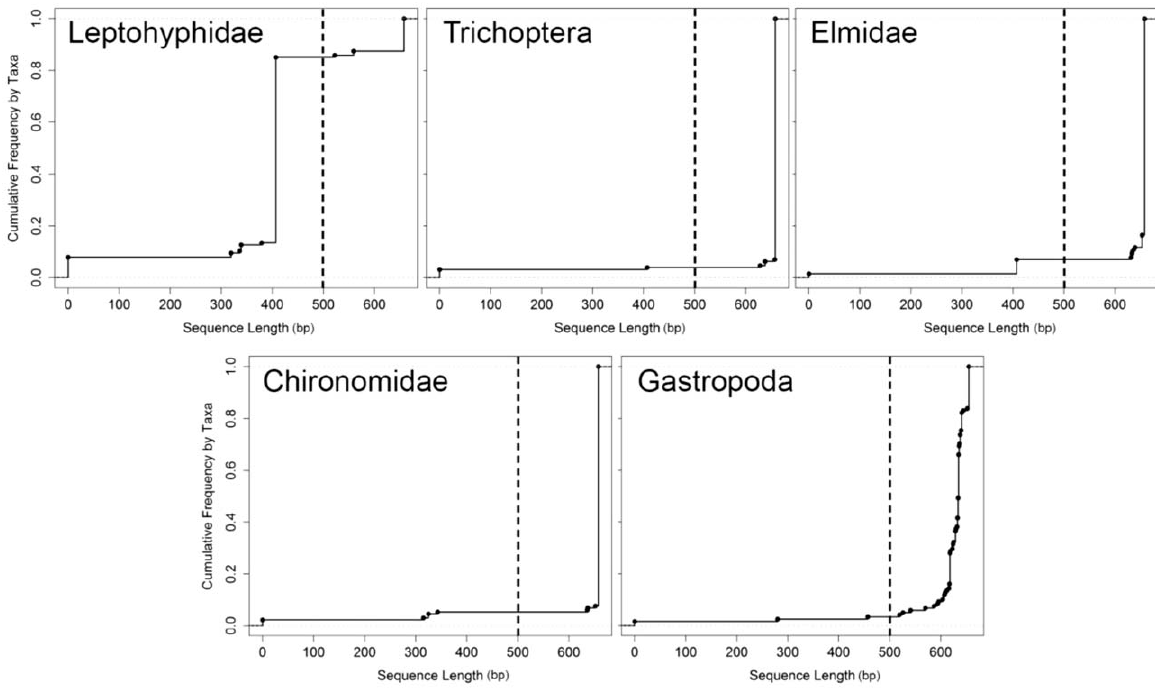
Figure 3. Cumulative frequency graphs of sequence length (base pairs) by lower taxa. Circles represent the points at which additional sequences are accumulated. Dashed horizontal lines represent the cutoff between partial barcodes (to the left) and full barcodes (to the